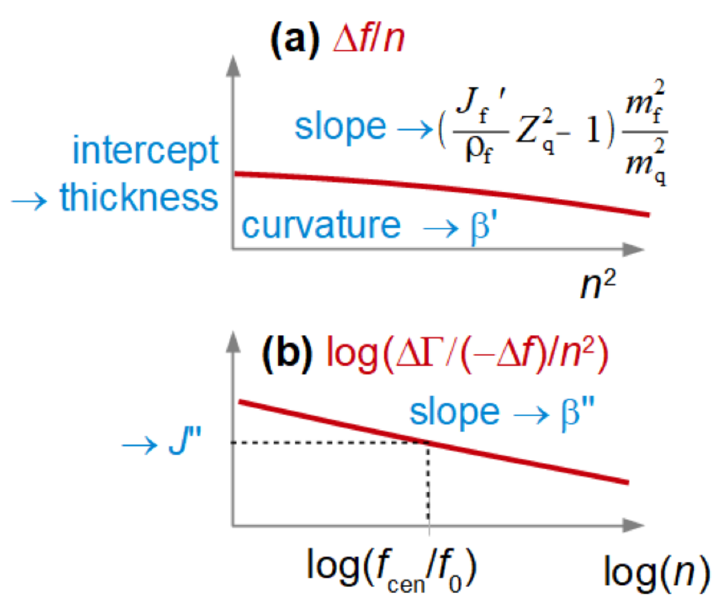
Figure 4. For a thin film in air, the set of parameters { d f , J f (cid:48) , J f ”, β (cid:48) , β ”} can be derived from plots of ∆ f / n versus n 2 ( a ) and log( ∆Γ /( − ∆ f )/ n 2 ) versus log( n ) ( b ), as shown above. Arrows indicate which system parameters are derived from certain features of the